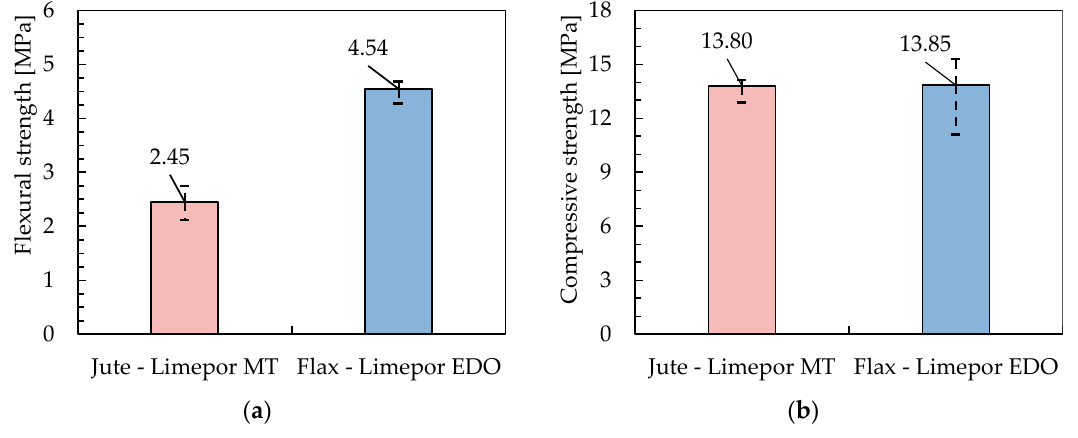
Figure 15. Flexural strength ( a ) and Compressive strength of mortars ( b ).